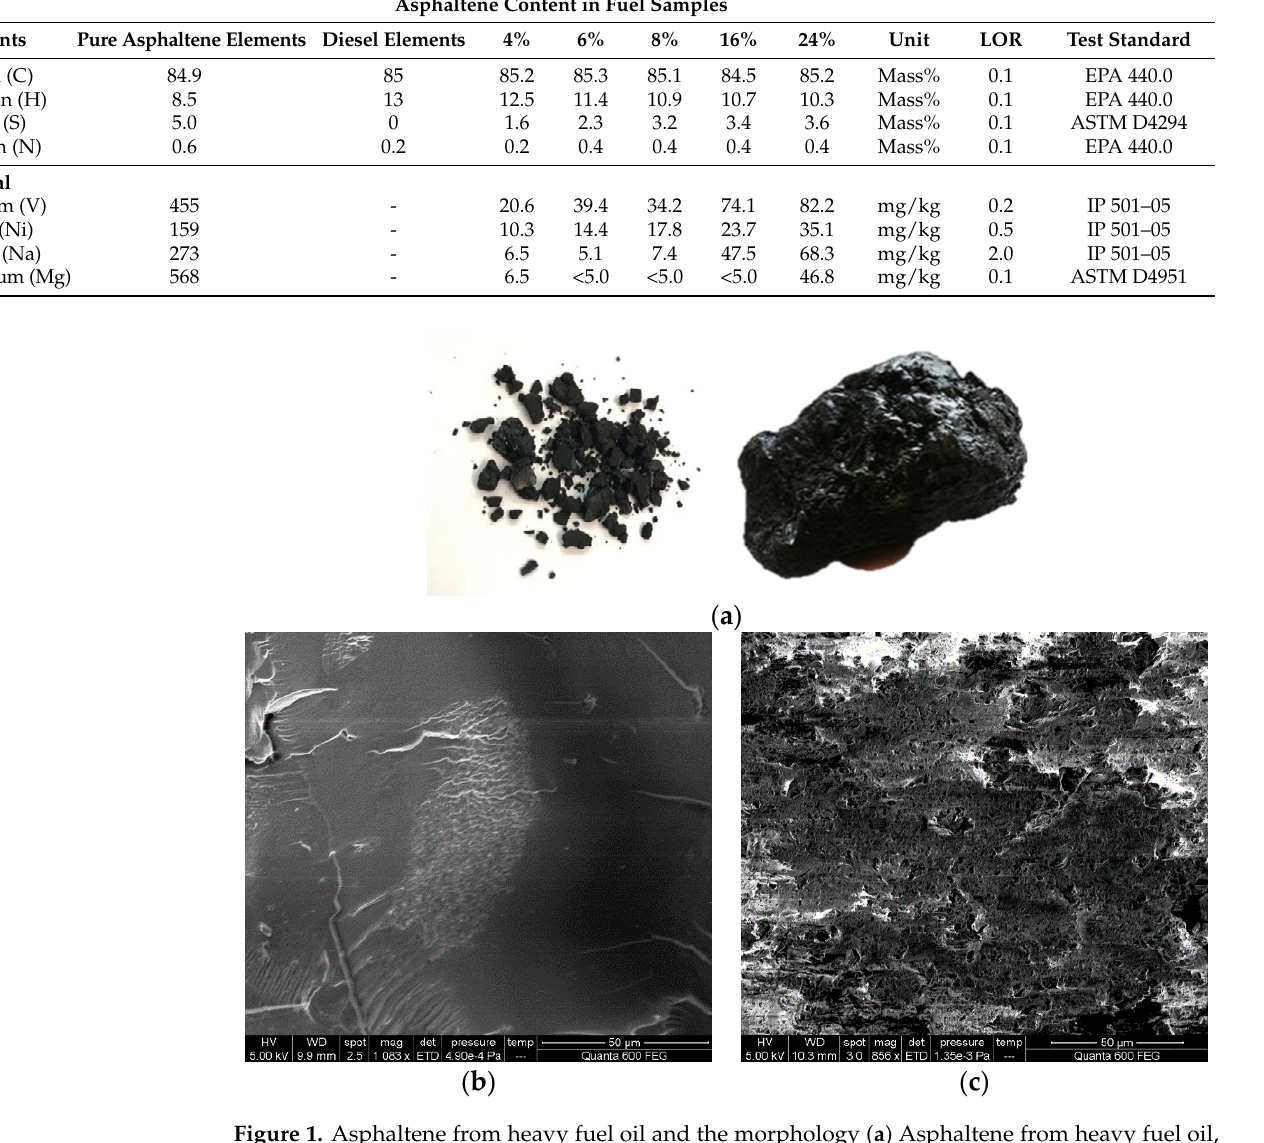
Figure 1. Asphaltene from heavy fuel oil and the morphology ( a ) Asphaltene from heavy fuel oil, ( b ) Surface of asphaltene, ( c ) Cross-section of asphaltene. Table 2. Element compositions of the fuel samples.